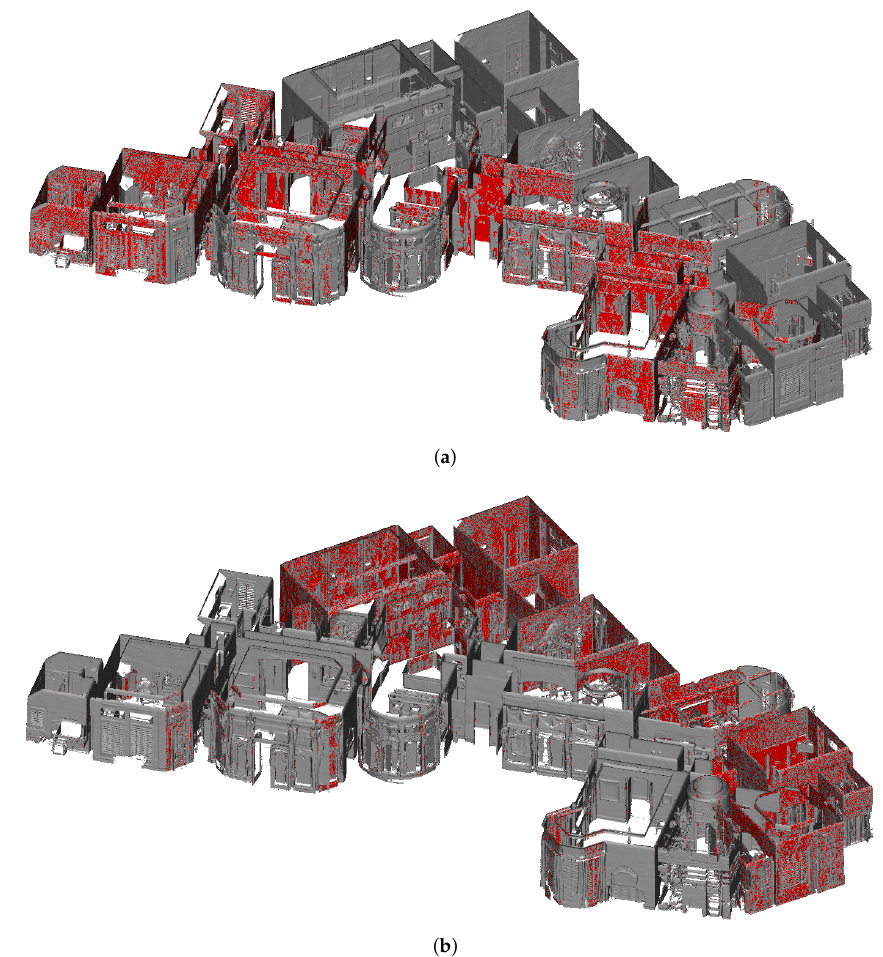
Figure 6. The horizontal faces of the triangle mesh presented in Figure 2 corresponding to the horizontal normal vectors (cid:126) n h . The faces corresponding to the two peaks shown in Figure 5 are i depicted in red. ( a ) Faces corresponding to the largest peak at 60° in Figure 5 determining the dominating Manhattan World structure. ( b ) Faces corresponding to the minor peak at 15° in Figure